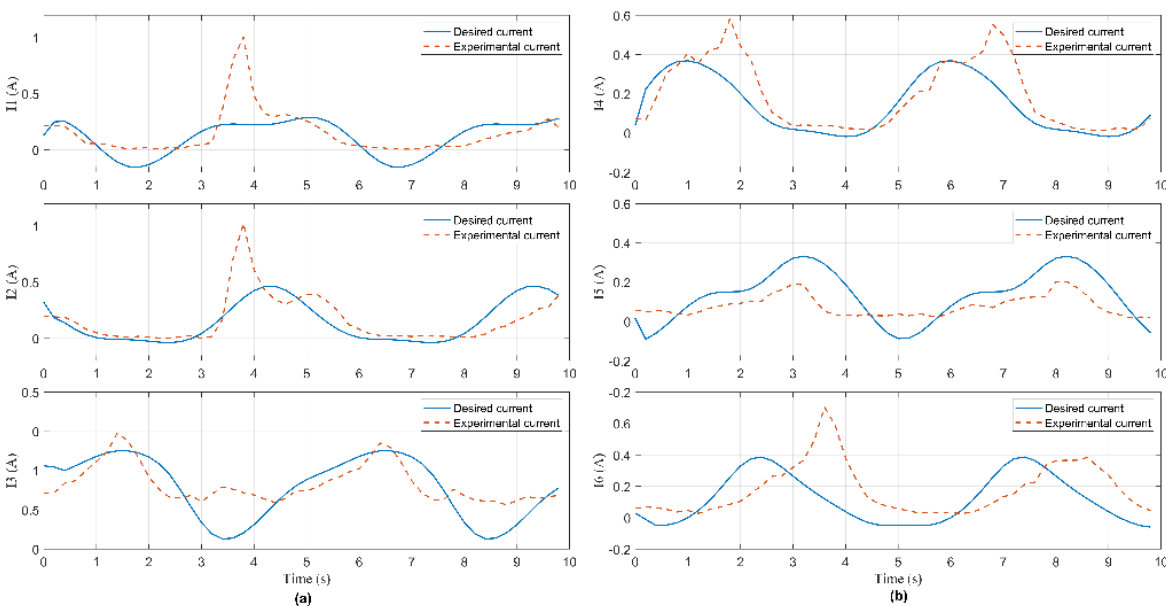
Figure 10. Current signal measured from current sensors in Case 1: (a) The 1 st , 2 nd , and 3 rd sensor; (b) the 4 th , 5 th , and 6 th sensor.